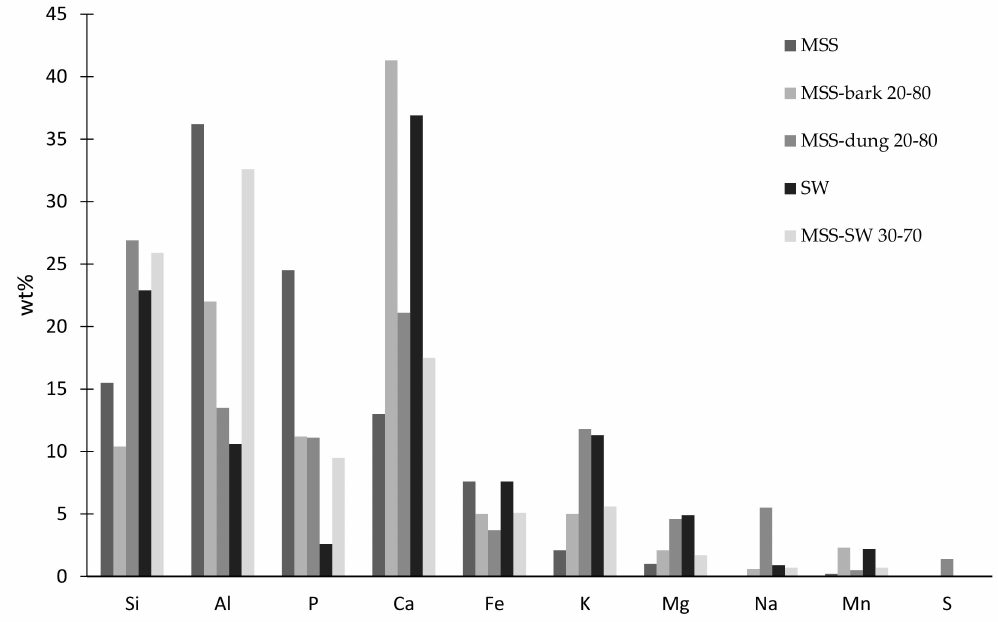
Figure 5. Major element distribution (map sum spectra representation) from SEM-EDX analysis of the samples MSS, MSS bark 20–80 and MSS dung 20–80, SW and MSS-SW 30–70 on carbon and oxygen free